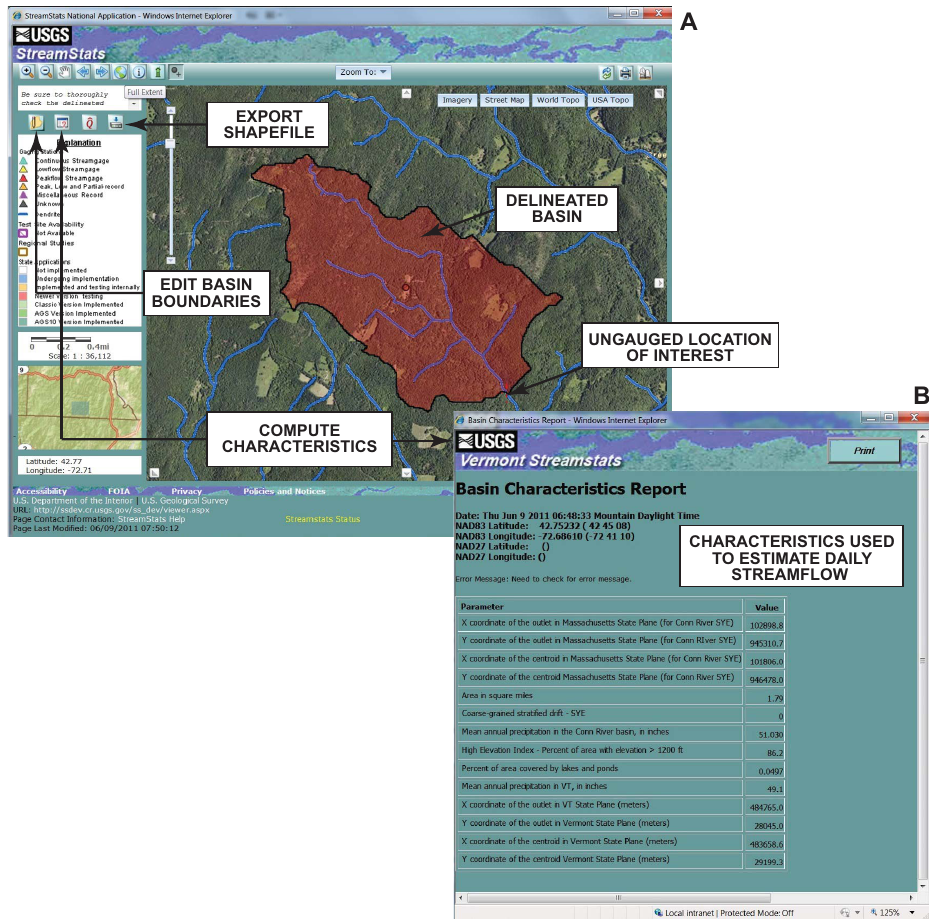
Fig. 3. Screen captures showing the map portion of the software tool used to estimate daily, unregulated time series. The program delineates a catchment (or basin, as named in the tool) for the ungauged location selected by the user (A) and summarizes the catchment characteris- tics (B) . The user also has the option to export the shapefile of the delineated catchment or edit the catchment boundaries (A)